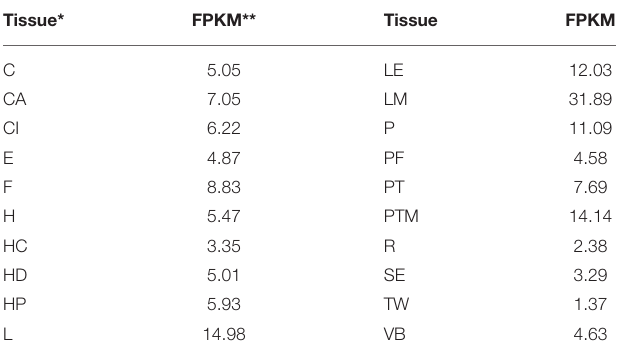
TABLE 1 | Expression of JrPDS in 20 different tissues.